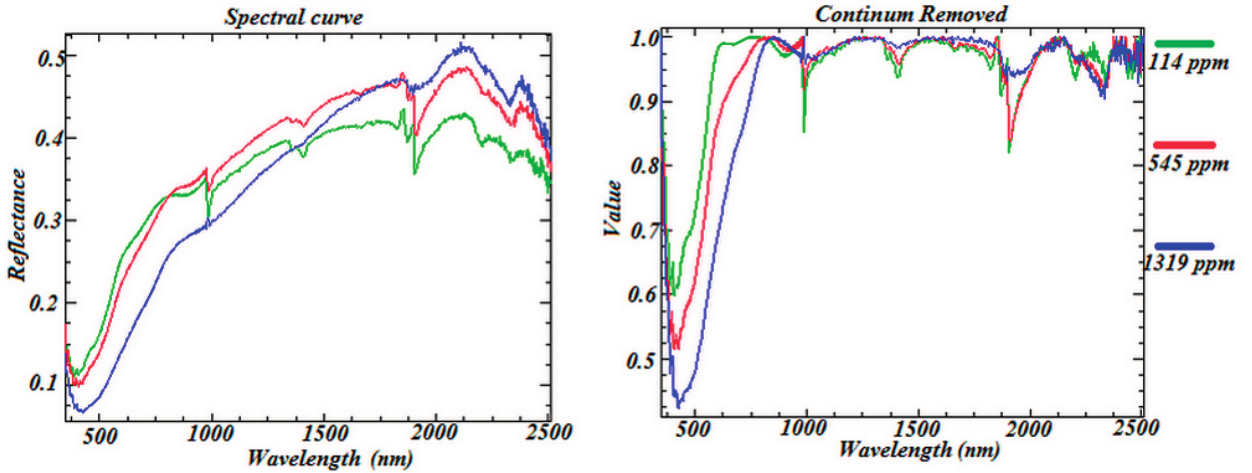
Figure 5. Continuum removed and spectral curves for samples with high lead content.